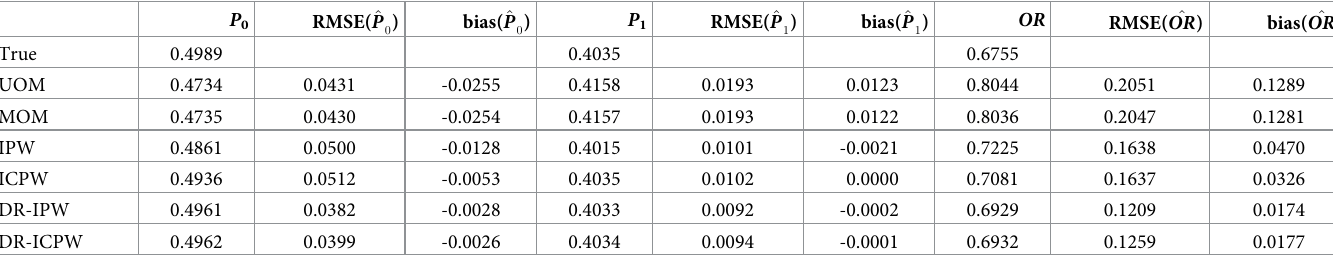
Table 10. Result of scenario 4, a general simulation setting with stronger confounders.